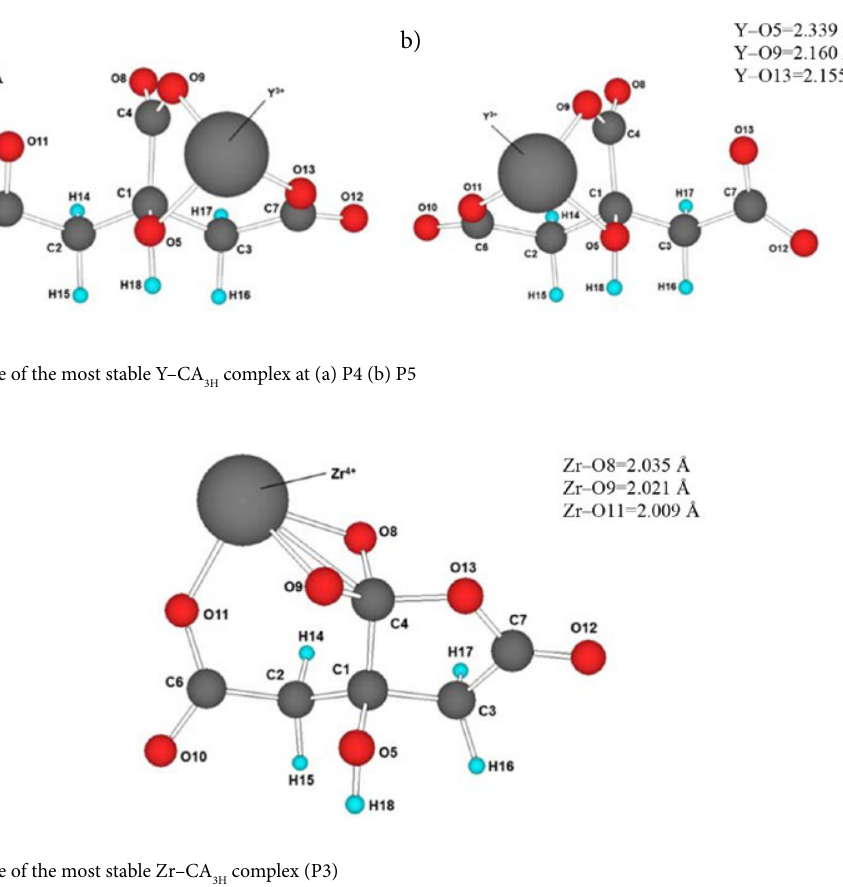
complex at (a) P4 (b) P5